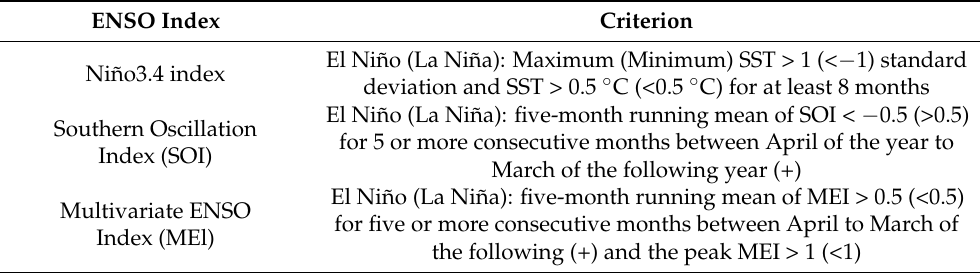
Table 2. Criteria for defining ENSO years based on three indexes [Source: NCC/CMA]. ENSO Index